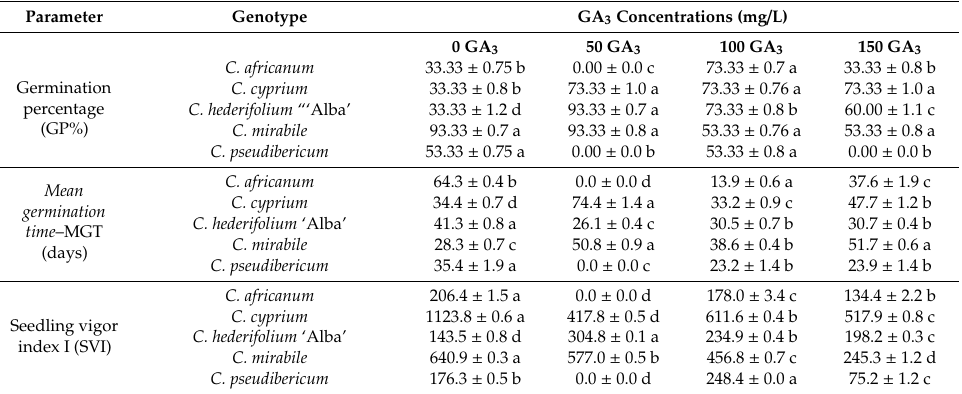
Table 2. E ff ects of increasing GA 3 concentrations (mg / L) on the indicated seed germination parameters of the five selected Cyclamen